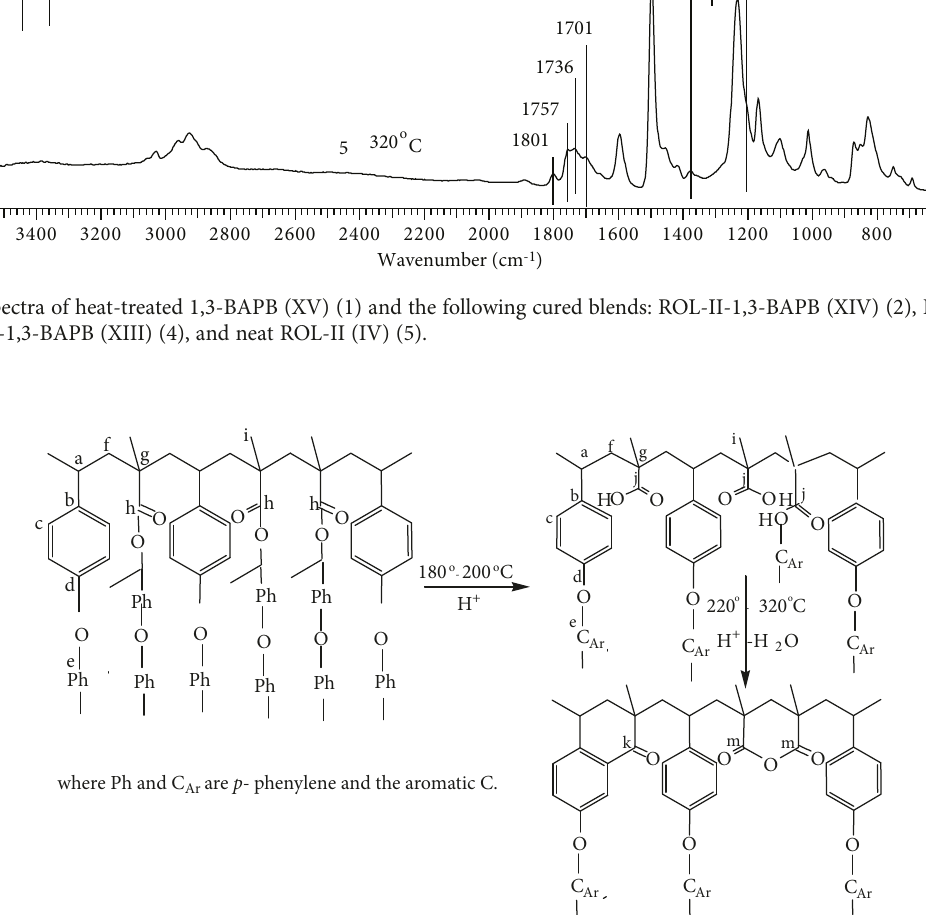
Figure 5: Chemical structures of the neat and restructurized ROL